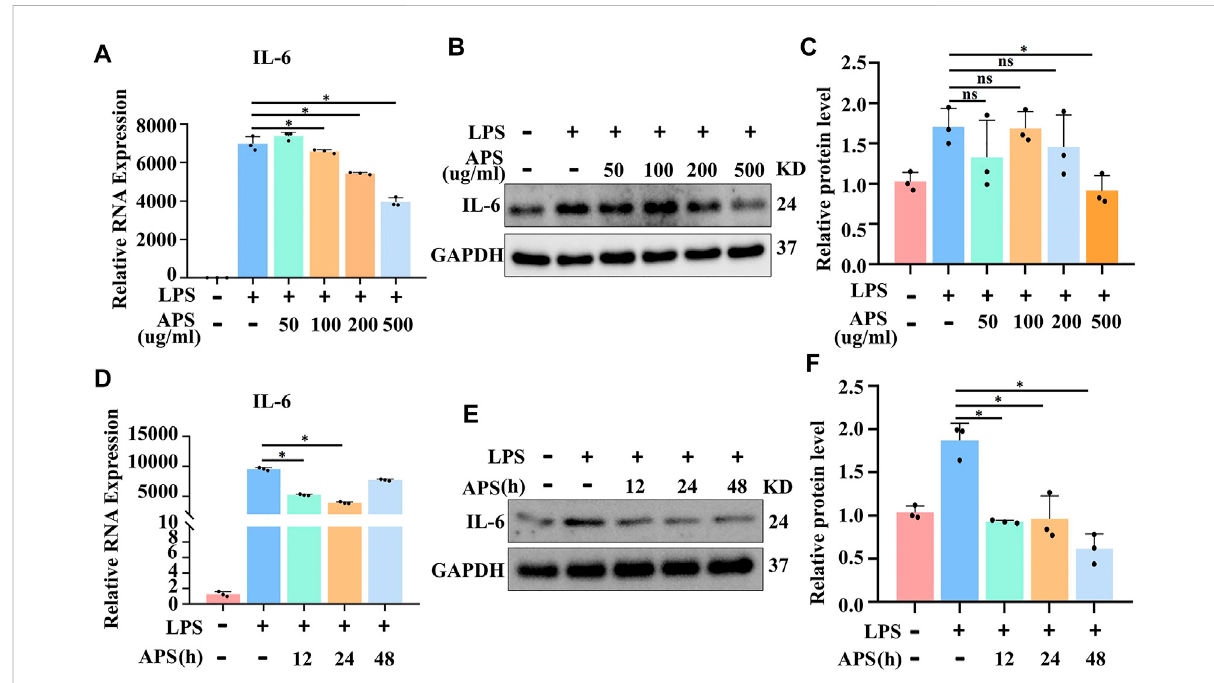
FIGURE 1 APS abrogated LPS-induced IL-6 gene expression in THP-1 macrophages. THP-1 macrophages were treated with APS (50, 100, 200, 500 μ g/ ml)for24 handtheninducedwithLPS(10 μ g/ml)for4 h (A) IL-6mRNAwasdetectedbyqRT-PCR. (B) IL-6proteinwasdetected bywesternblot. (C) Densitometry quanti fi cation of protein. THP-1 macrophages were treated with APS (500 μ g/ml) for different time (0, 12, 24, 48 h) and then induced with LPS (10 μ g/ml) for 4 h (D) IL-6 mRNA was detected by qRT-PCR. (E) IL-6 protein was detected by western blot. (F) Densitometry quanti fi cation of protein. * p < 0.05 compared with LPS group. Data represent the mean ± SEM. n = 3 per